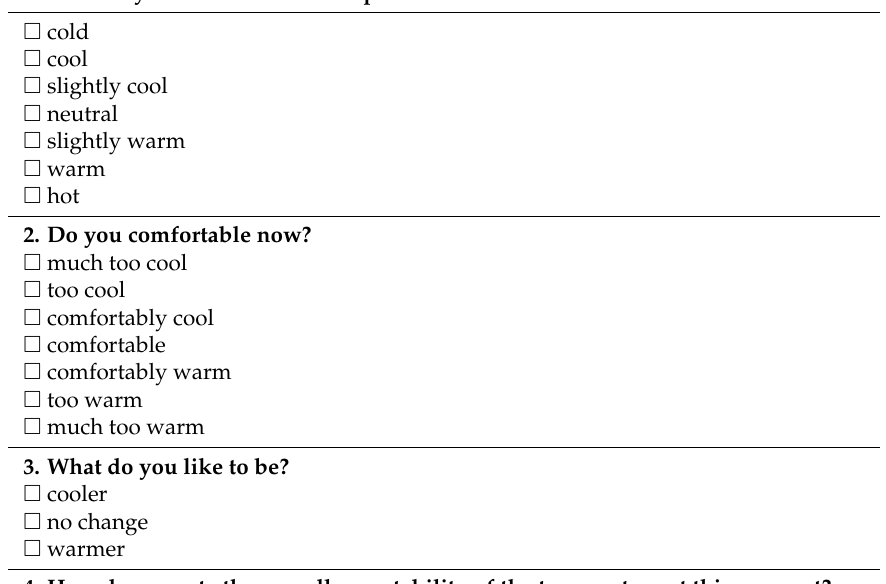
Table 4. Thermal comfort questionnaire (adapted from